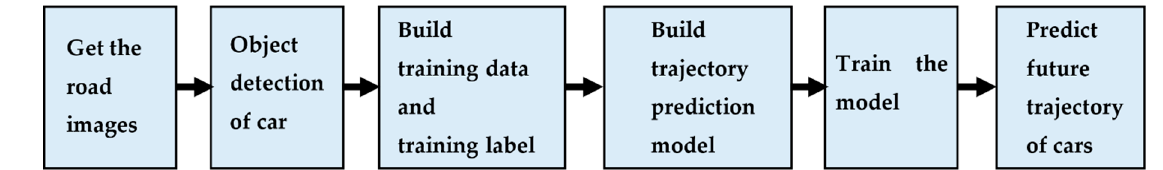
Figure 16. Steps of the trajectory prediction of cars.